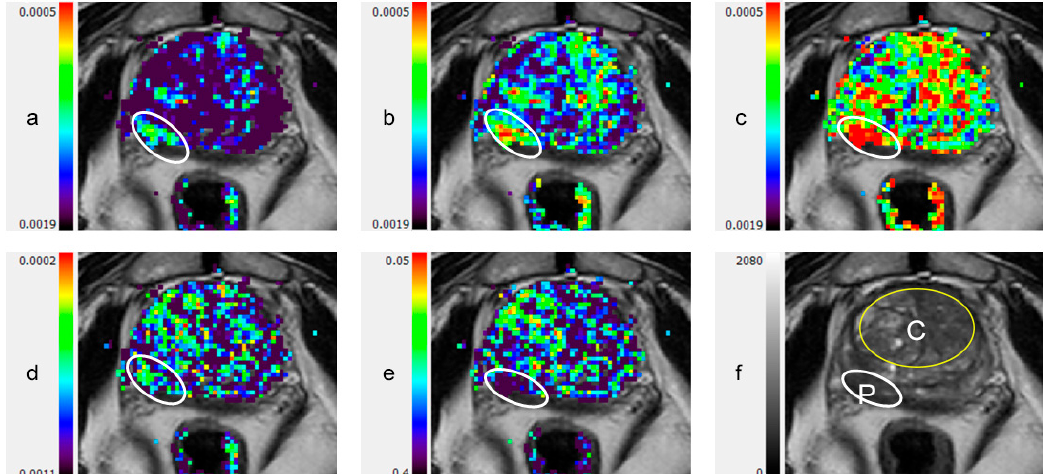
Figure 1. Peripheral zone lesion on color coded DTI Maps and T2-weighted image: ( a ) λ 1 ; ( b ) λ 2 ; ( c ) λ 3 ; ( d ) maximal anisotropy (MA); ( e ) fractional anisotropy (FA); ( f ) T2-weighted image. C: central gland (transitional zone and central zone); DTI: diffusion tensor imaging; P: peripheral zone; White ellipsoid in ( a ) to ( e ): peripheral zone lesion.